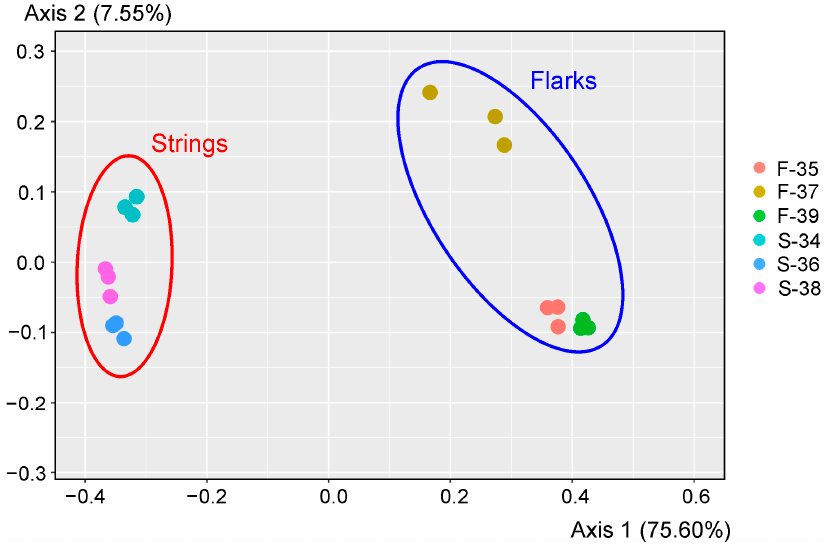
Figure 2. Comparison of microbial community composition in analyzed peat samples by principle coordinate analyses (PCoA). PCoA plot is based on weighted UniFrac distance of 16S rRNA sequencing dataset.